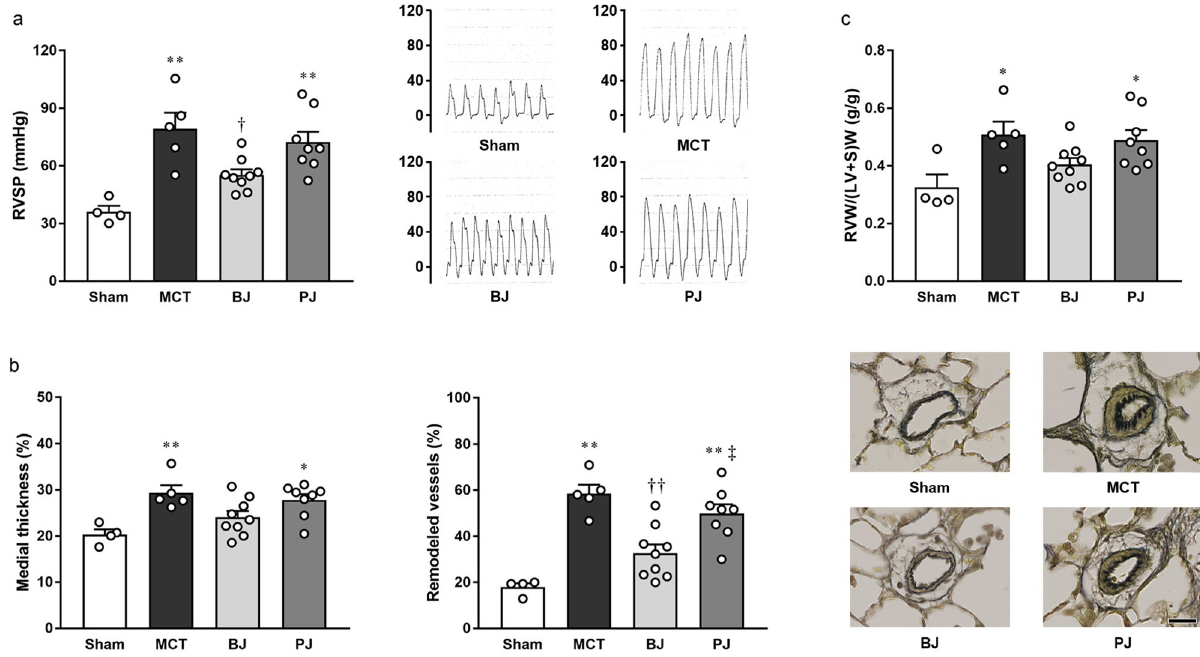
Fig 3. Effects of nitrate-depleted BJ supplementation on PH symptoms in MCT-injected rats. (a) RVSP (left panel) and typical tracings (right panel). (b) Pulmonary arterial medial thickening (left panel), remodeling (middle panel), and typical images (right panel; scale bar, 25 μ m). (c) RVW/ (LV+S)W. Each point represents individual value; each column and bar represent the mean ± SEM values of 4–9 experiments. � p < 0.05 and �� p < 0.01, compared to the sham group; † p < 0.05 and †† p < 0.01, compared to the MCT group; ‡ p < 0.05, compared to the BJ group. Statistical